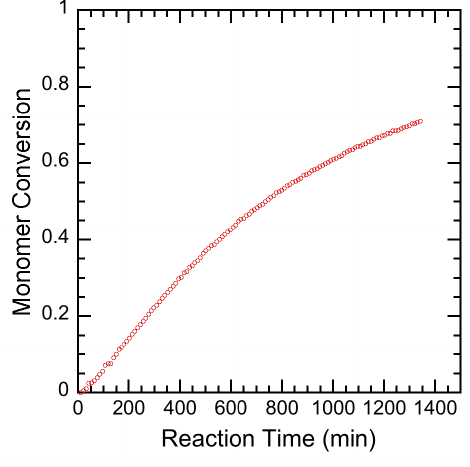
Figure A4. Polymerization kinetics (monomer conversion) of PMMA-4 as determined by in situ 1 H NMR